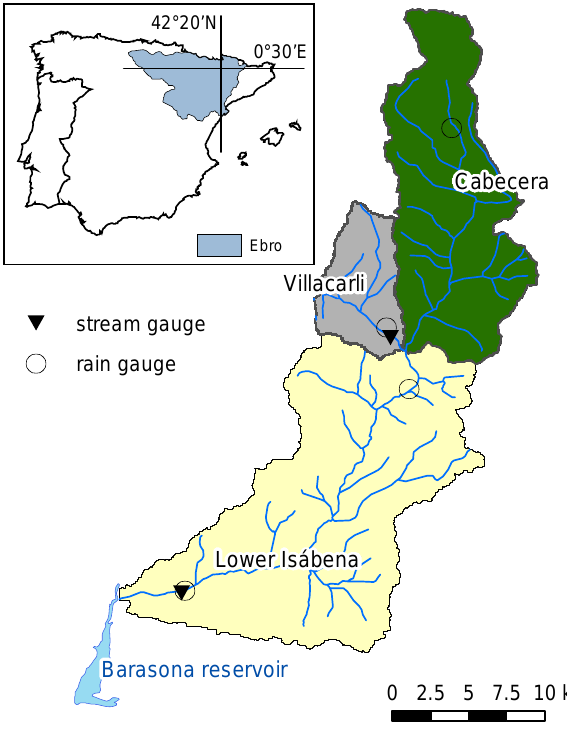
Fig. 4. Is´abena catchment and its Figure 4: Isábena catchment and its sub-catchments